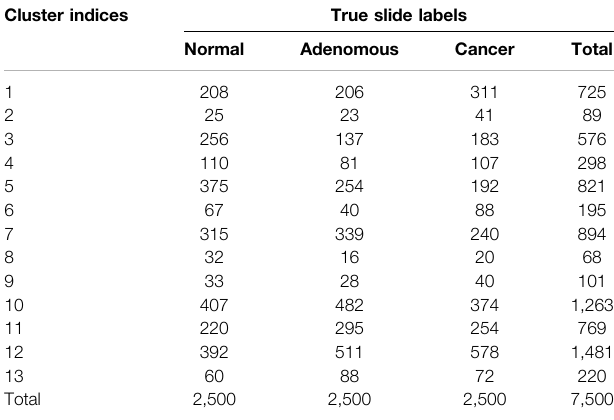
TABLE 1 | Confusion of grid instances between clusters and slide labels. Cluster indices